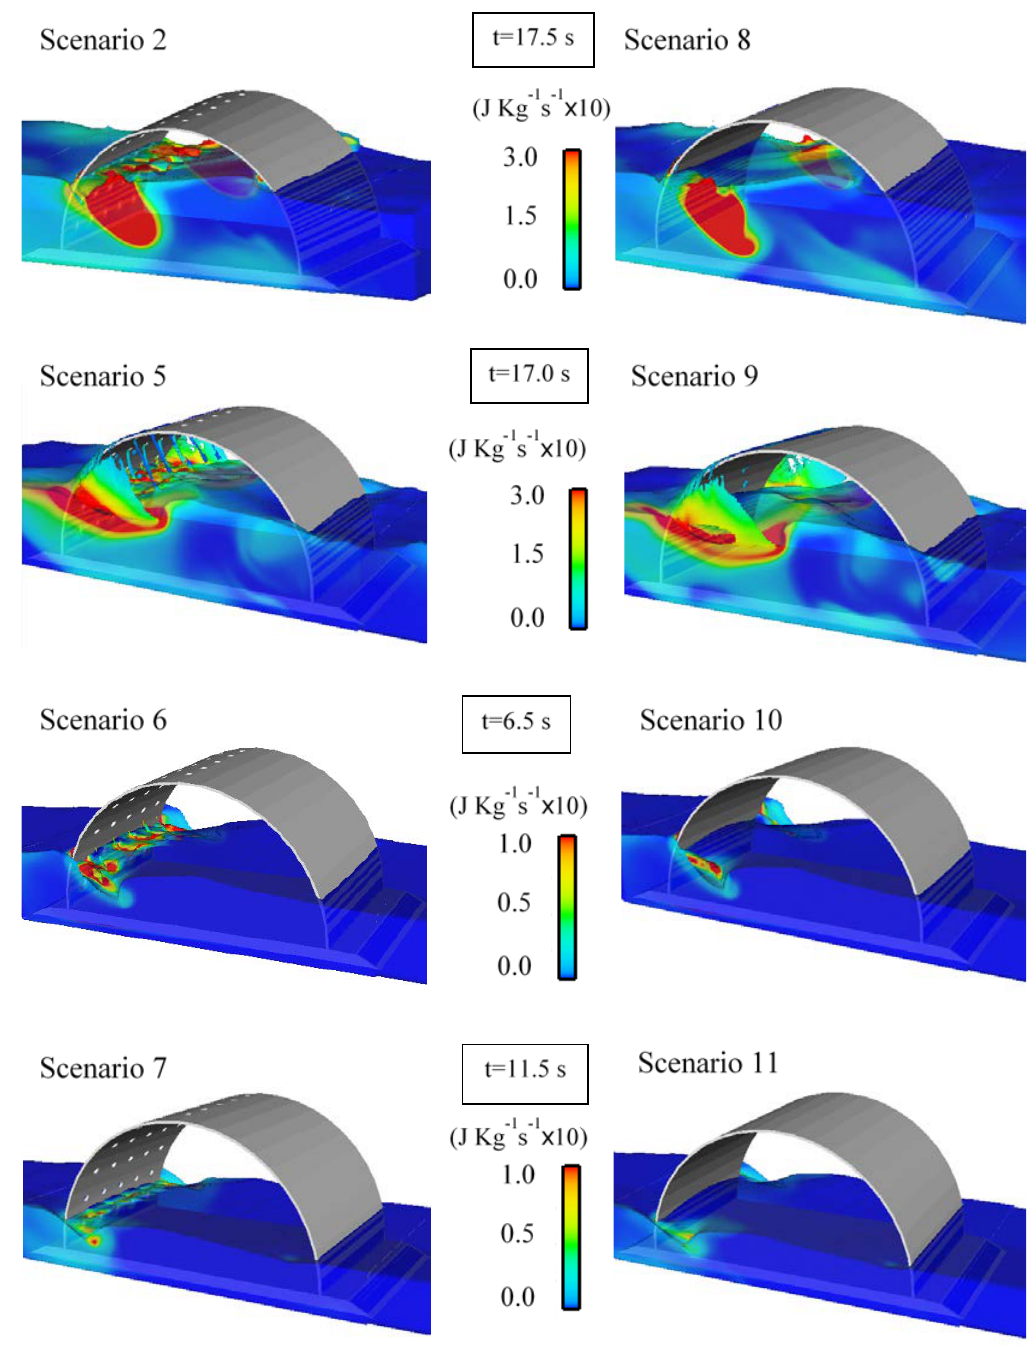
Figure 6. Turbulent kinetic energy dissipation: perforated semicircular breakwater (left) and non-perforated semicircular breakwater (right).